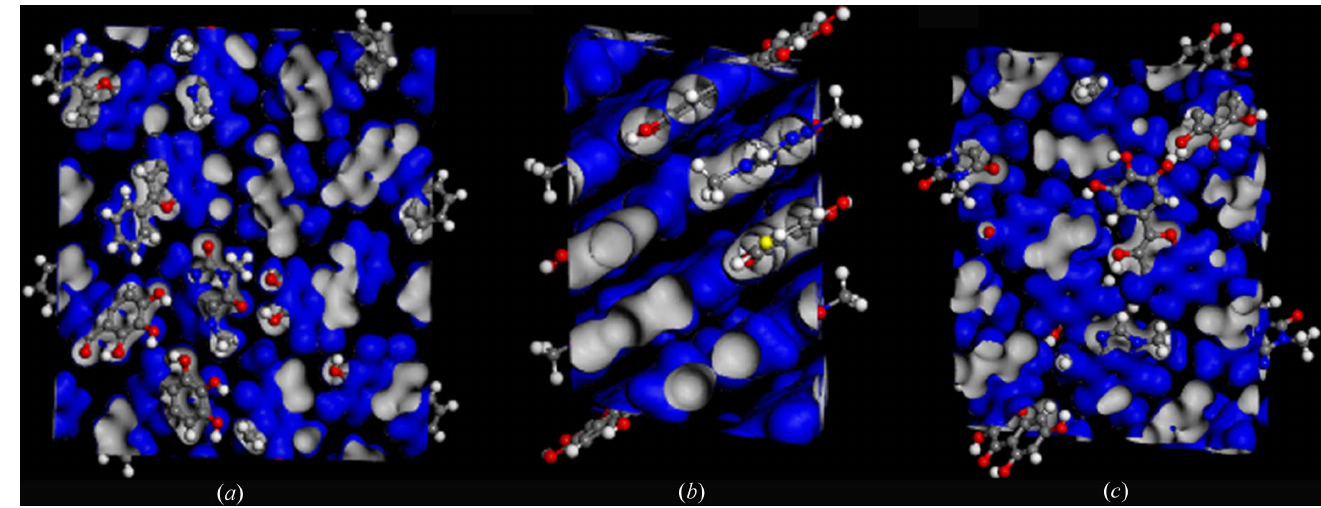
Figure 8 Electron density of three different cocrystals ( a ) BAI–CAF, ( b ) QUE–CAF, ( c )